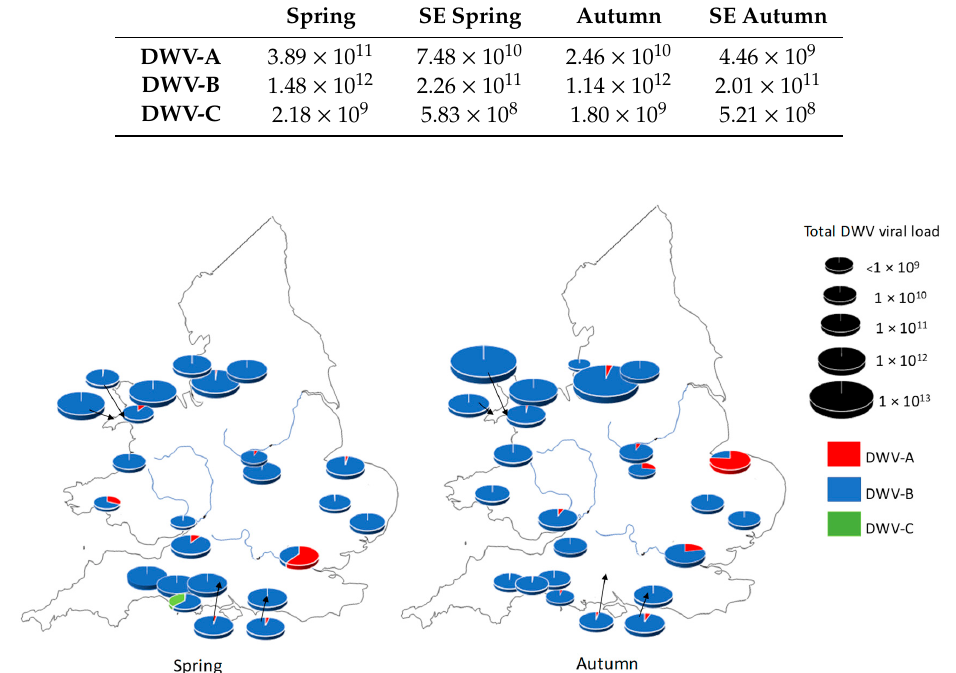
Figure 1. A map of England and Wales showing the average DWV load and variant per